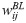
Distributions of synaptic connection weights (wijBL) before (pink) and after (blue) training for the full AN-CN-IC-CX model (top row) and reduced AN-CX model (bottom row).The ordinate is log scaled.